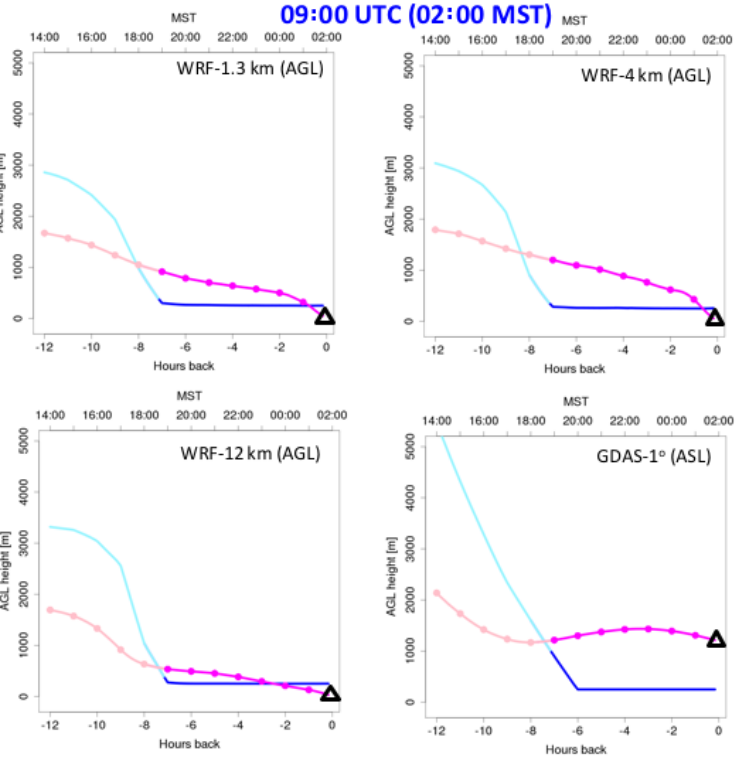
Figure 12. Similar to Fig. 10, but for the Niwot Ridge (NWR)